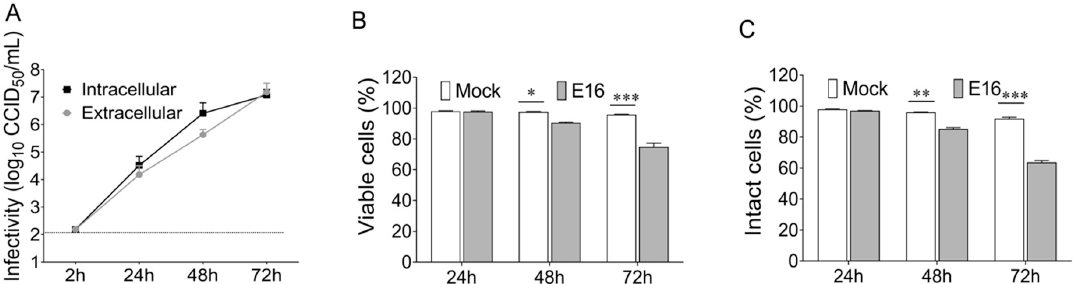
Figure 1. Pre-lytic release of echovirus 16 (E16) in EndoC- β H1 cells. ( A ) Cells and corresponding culture supernatant were harvested at indicated time points after infection of EndoC- β H1 cells with E16 (MOI = 0.00001) and the intracellular virus production and extracellular virus release was determined by 50% cell culture infectious dose (CCID50) assay in green monkey kidney (GMK) cells. Dotted black lines indicate the limit of detection. ( B ) Cell viability measured by 3-(4.5-dimethylthiazol-2-yl)-2.5-diphenyltetrazolium bromide (MTT) assay and ( C ) plasma membrane integrity of EndoC- β H1 cells by determining lactate dehydrogenase (LDH) activity in culture supernatant at the indicated time points after E16 infection (MOI = 0.00001) compared to mock-treated cells. Data are presented as mean ± SEM for three independent experiments, with each measurement performed in triplicate. * p < 0.05, ** p < 0.01, *** p < 0.001.